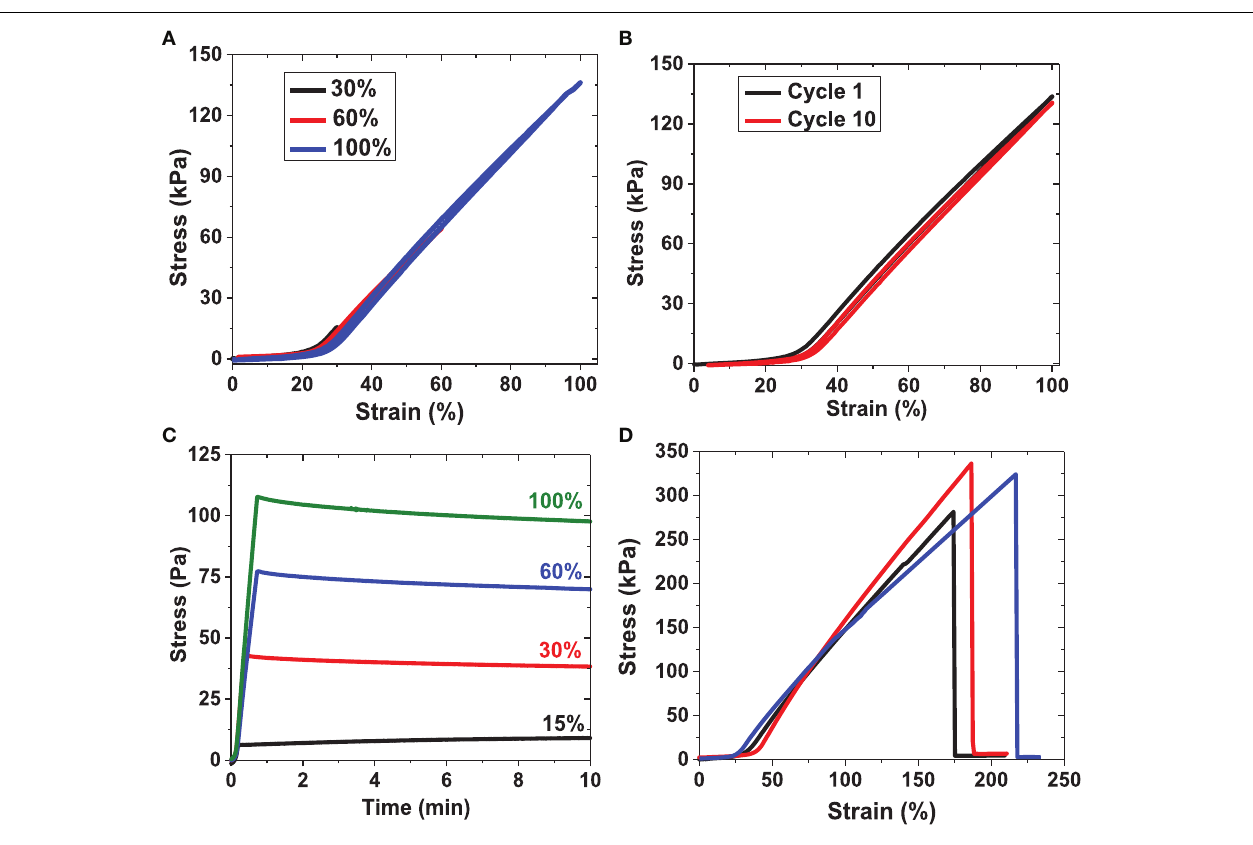
FIGURE 9 | Uniaxial tensile testing experiments for RLP hydrogels. (A) Third cycle of strain-loading and unloading up to 30, 60, and 100% strain for RLP hydrogel; (B) first cycle and tenth cycle of cyclic loading and unloading at 100% strain of RLP hydrogel; (C) stress relaxation of RLP hydrogel at 15, 30,